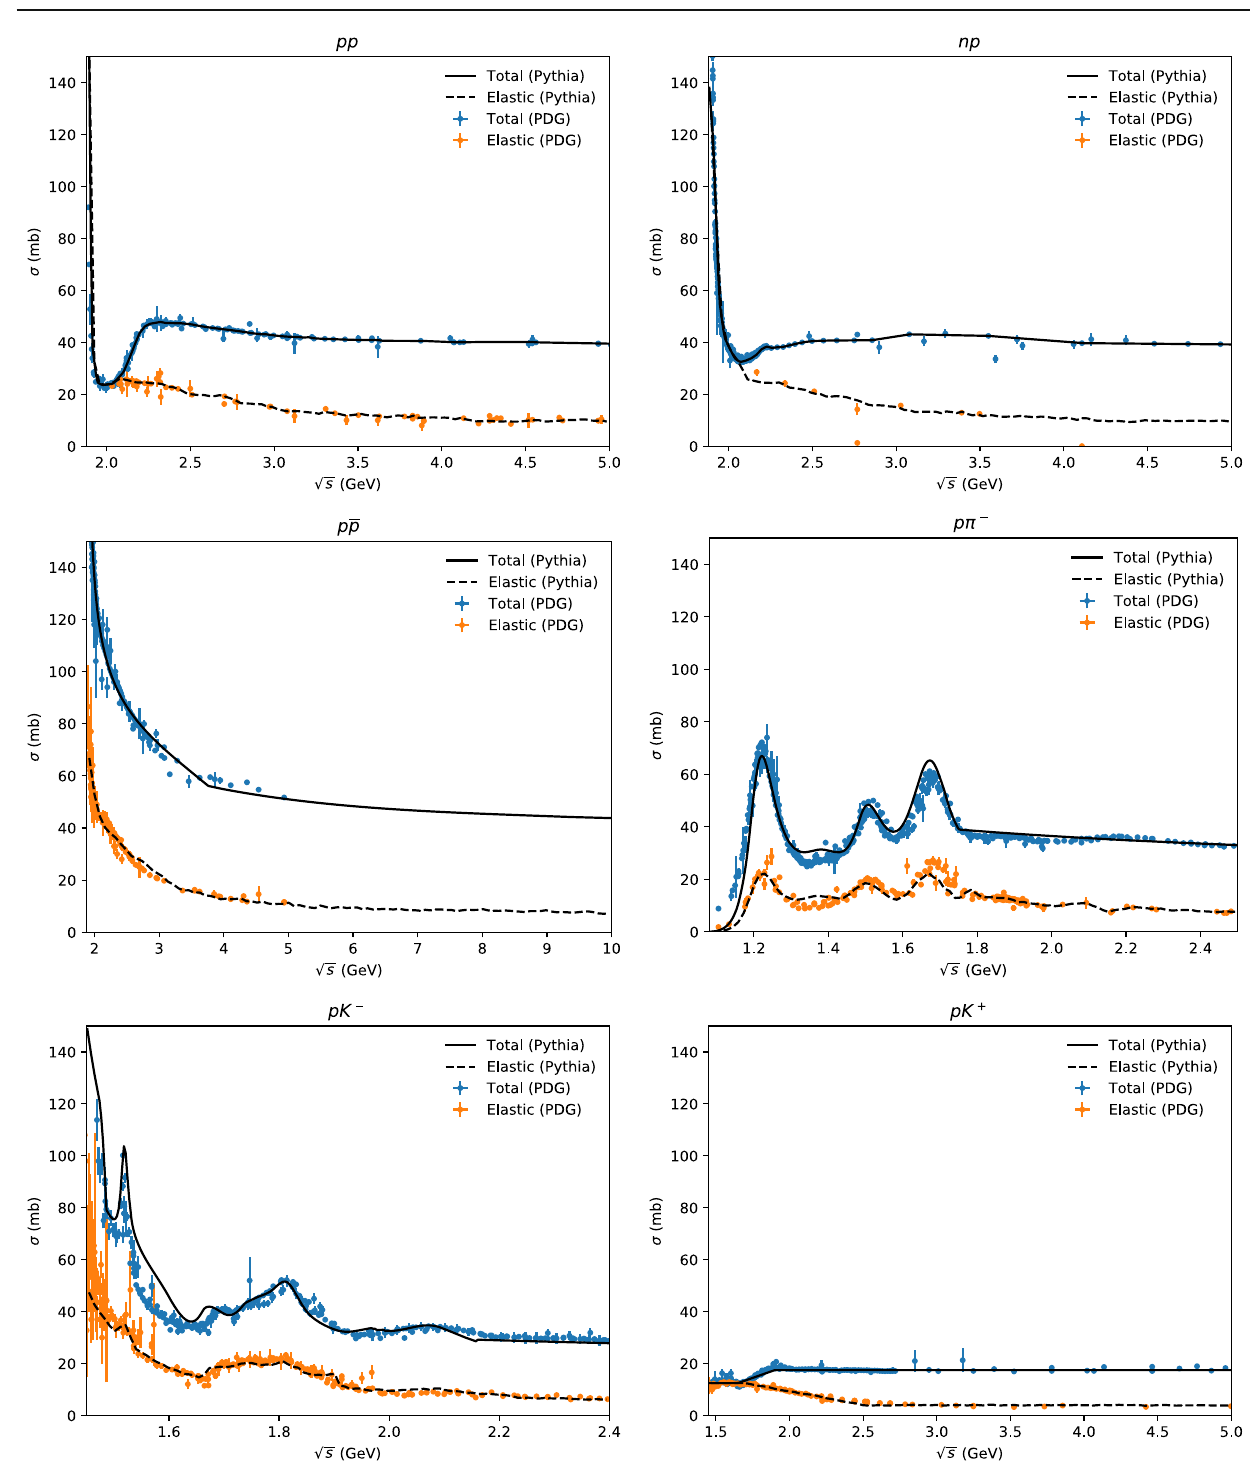
Fig. 2 Total and elastic cross sections for some important processes. The elastic cross sections for p π − and pK − include elastic scattering through a resonance, AB → R → AB , which notably do not correspond to the elastic cross sections calculated in Sect.